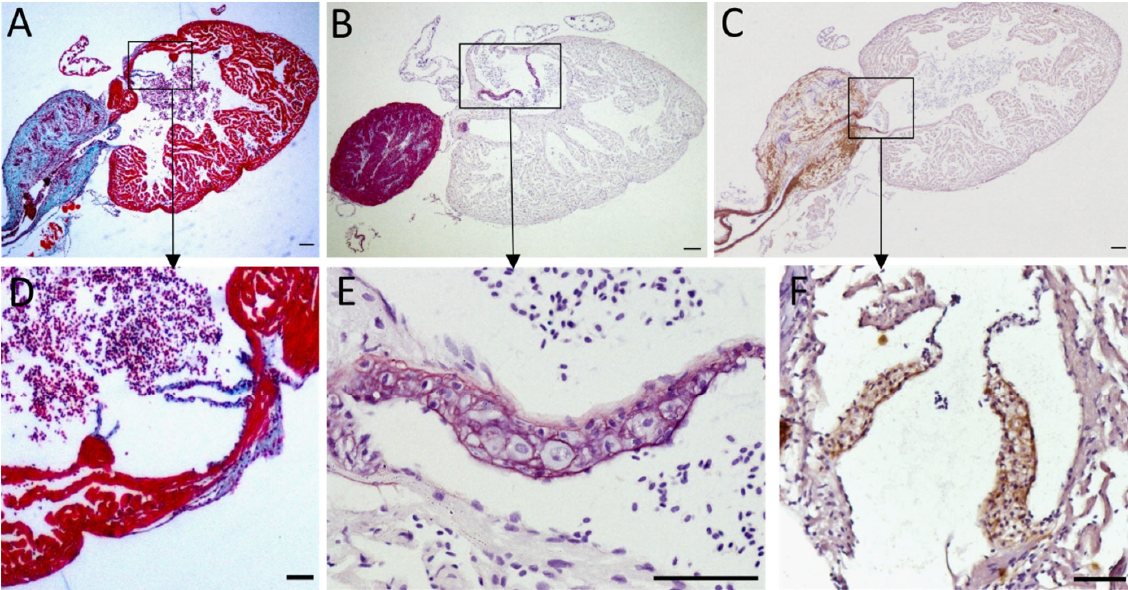
Figure 3. Elastin content of the zebrafish heart. Histological sections of adult zebrafish entire hearts ( A – C ) and cardiac valves ( D – F ). Sections were stained following different protocols: Masson-Goldner trichrome staining ( A , D ) makes muscle fibers appear in red, collagen in blue, and erythrocytes in pinkish violet; orcein ( B , E ) stains elastin in pink and nuclei appear in violet due to hematoxylin staining; immunohistochemistry against elastin ( C , F ) with elastin signal appearing in brown; ( D , E ) are atrioventricular valves, ( F ) shows the bulboventricular valve. Scale bars: 100 μ m ( A – C ); 50 μ m ( D – F ). Magnification: 40× ( A ‐ C ); 200× ( D , F ); 00× ( E ).